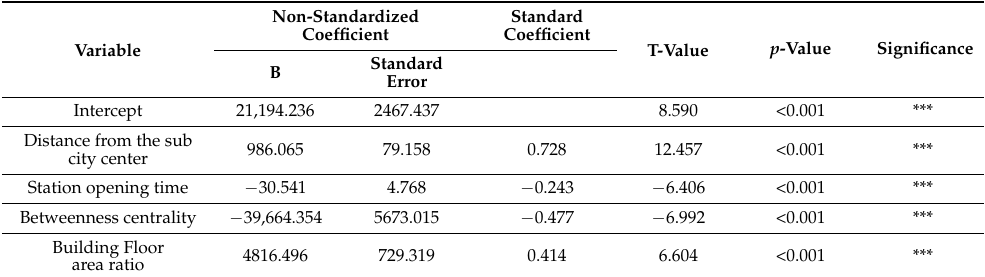
Table 7. Regression results of significant variables affecting travel distance for the elderly. Non-Standardized Coefficient Variable